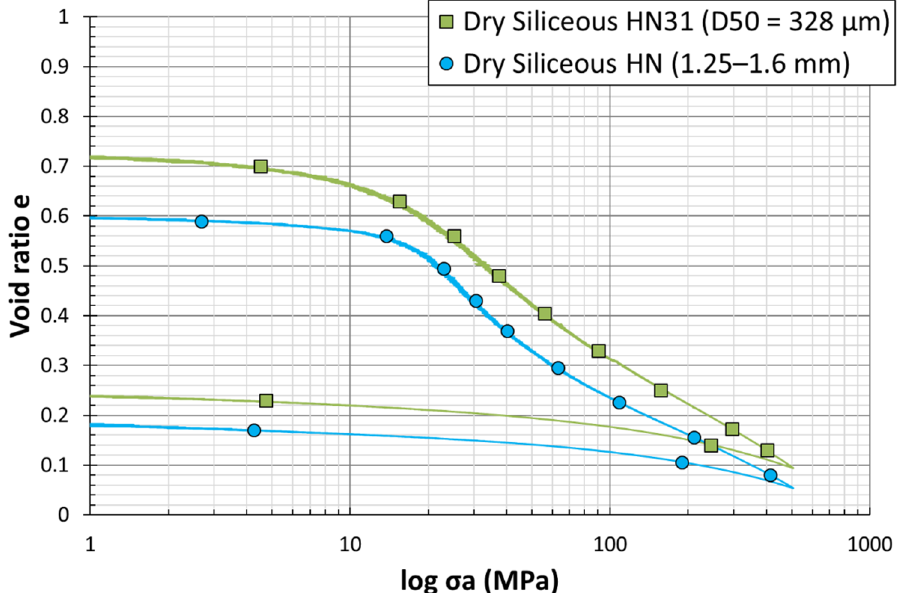
Figure 12. Load–settlement curves from dry odometer tests on siliceous sand grains of two different sizes ( D 50 = 328 µm vs. 1.415 mm).